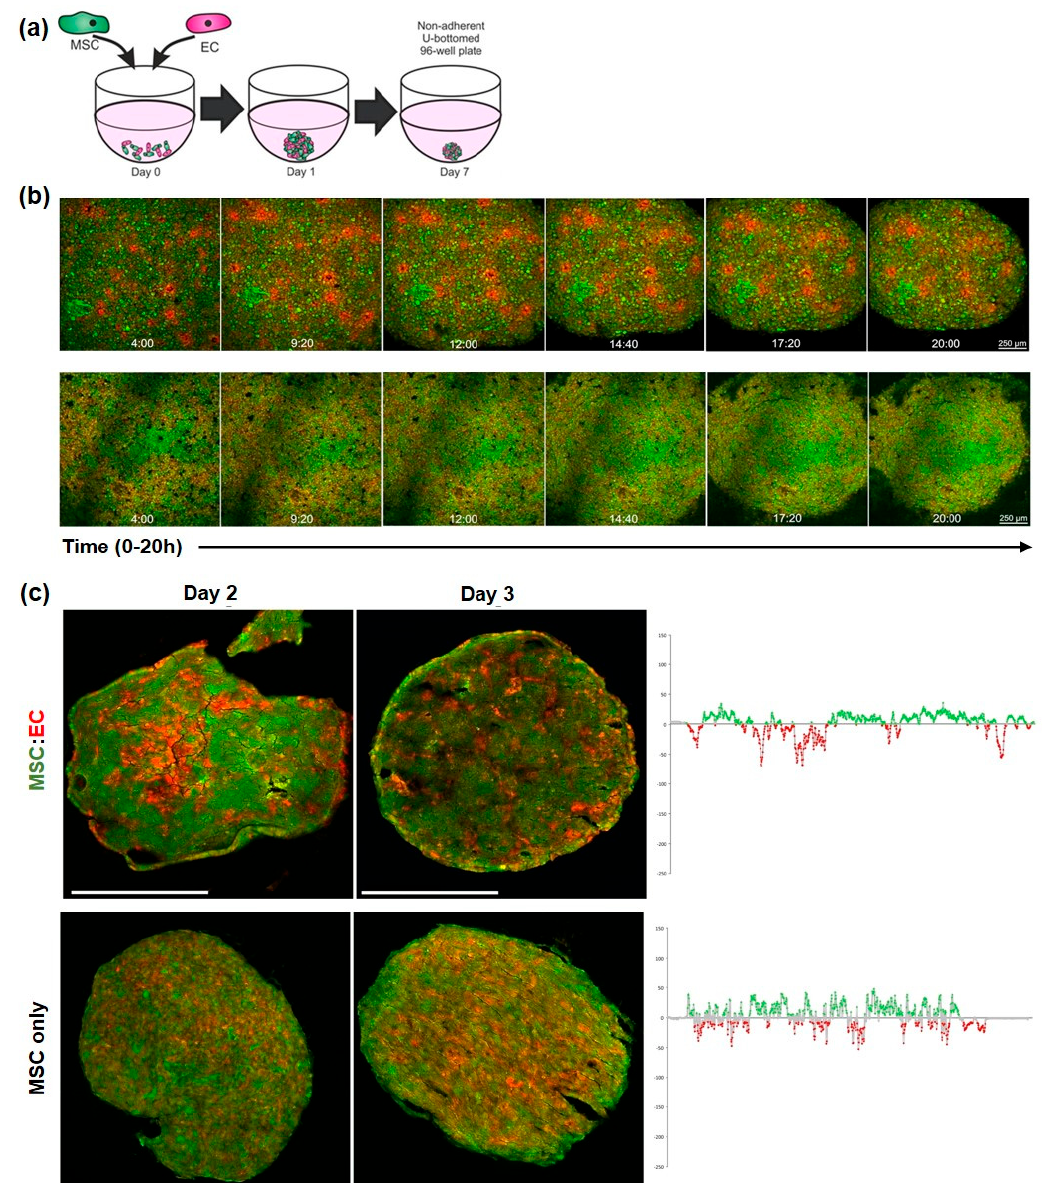
Figure 1. Fluorescent imaging of MSC-ECs during spheroid formation. ( a ) Schematic showing technique for combining MSCs and ECs to form co-cultured spheroids containing 30,000 cells in total per well of the non-adherent U-bottomed 96-well plate. ( b ) Top: Time-lapse images of MSC-EC (50:50) spheroid formation; MSCs labelled green, ECs labelled red; Bottom: MSC-only control containing 50:50 MSC (green):MSC (red). Images were captured every 20 min from 4 h to 20 h, sample time points shown. ( c ) Higher magnification images of MSC:EC (top) and MSC-only (bottom) spheroid sections at days 2 and 3 of culture, all scale bars = 200 μ m. Graphs on the right quantify green-red cell distribution across the centre line of sections from day 3 spheroids using the plot profiler extension on Image J. The data show the distribution of green-labelled cells as positive values above the x-axis and red-labelled cells as negative values below the x-axis.